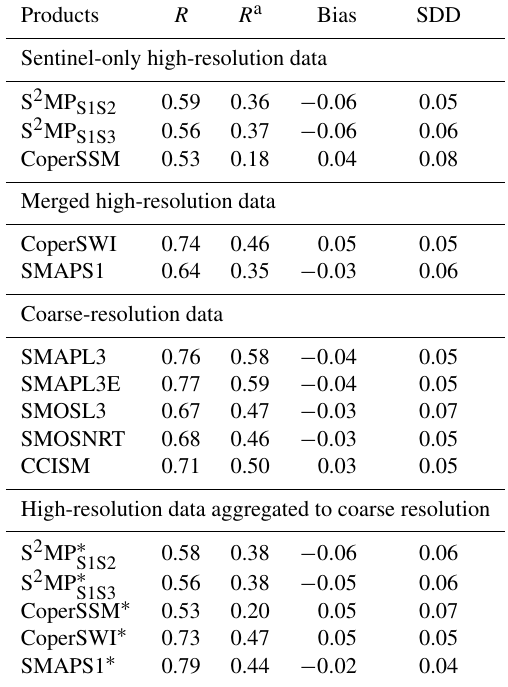
Table 3. Evaluation of the HR and CR SM time series against in situ measurements in terms of the Pearson correlation ( R ; R a ), bias (re- motely sensed minus ground-based SM in m 3 m − 3 ), and standard deviation of the difference (SDD in m 3 m − 3 ). The metrics were computed by taking into account the six regions of study, and only the median values are shown here. The asterisk ∗ indicates the HR datasets averaged at 25km resolution. The analysis was performed from January to December